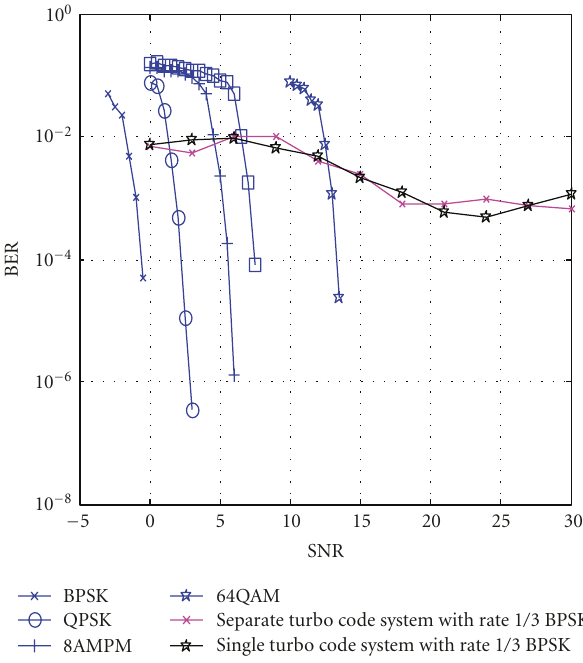
Figure 10: BER of separate turbo code system and one turbo code system with rate 1/3 BPSK.